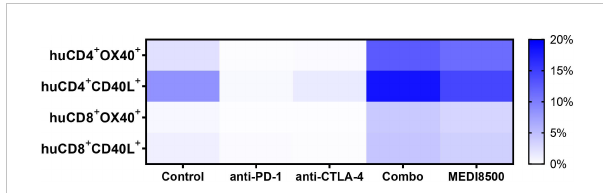
FIGURE 4 Signi fi cant activation of T cells with antibody combination and MEDI8500 compared to monotherapies. Percentage of huCD4 + and huCD8 + T cells expressing T cell activation markers in terminal blood of mice in the different groups of treatment. Data were analysed by fl ow cytometry and represented as mean of all mice in each treatment group. Mice numbers are the same as in Figure 2A. A Mixed-effects analysis followed by Dunnett ’ s multiple comparisons test was used to evaluate statistical differences between control and treated groups. A signi fi cant difference (*** P < 0.001) was noted in the antibody combination and MEDI8500 groups compared to the control group in the percentage of huCD4 + OX40 + T cells, huCD8 + OX40 + T cells and huCD8 + CD40L + T cells. * P < 0.05 was noted in the antibody combination and MEDI8500 groups compared to the control group in the percentage of huCD4 + CD40L + T